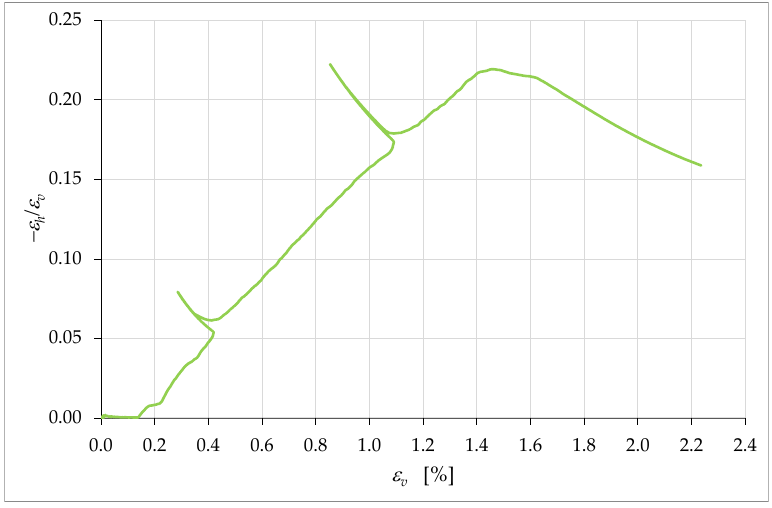
Figure 20. Curve of 𝜈 (apparent Poisson’s ratio) with respect to the axial strain, 𝜀 𝑣 .